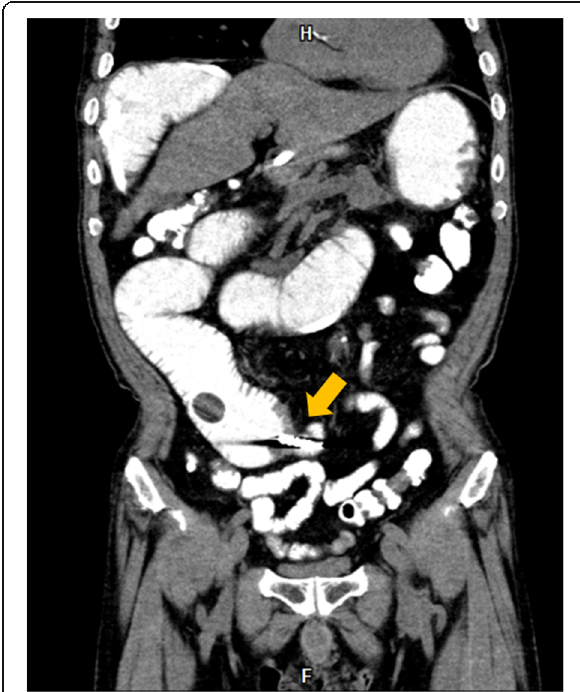
Fig. 5 Computed tomography (CT) enterography. CT enterography